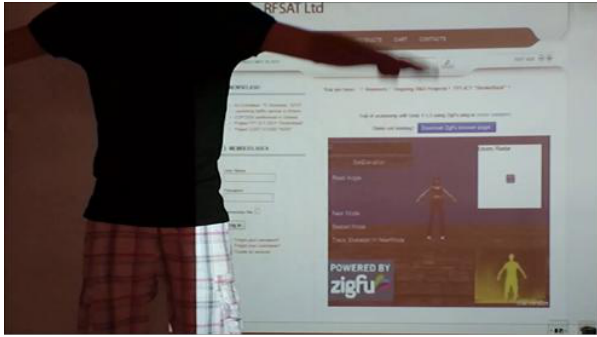
Figure 14. Real patient playing game online using